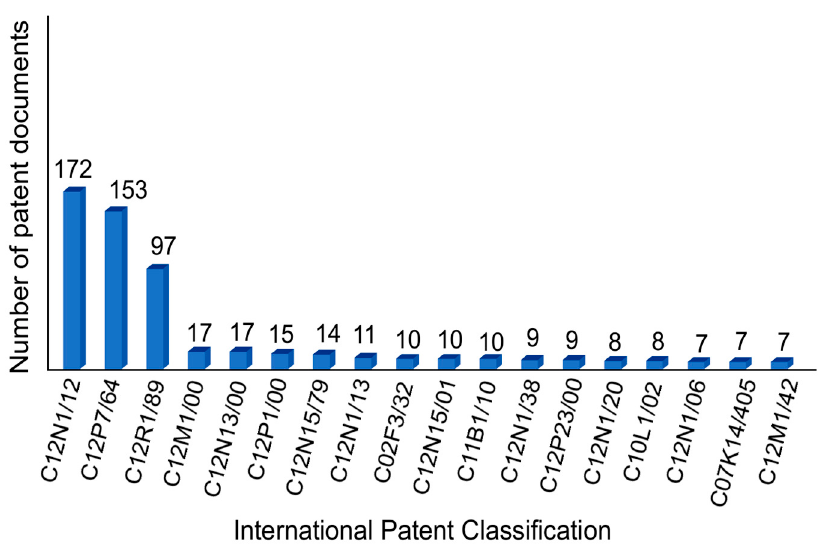
Figure 2. Distribution of patent documents by classification codes.